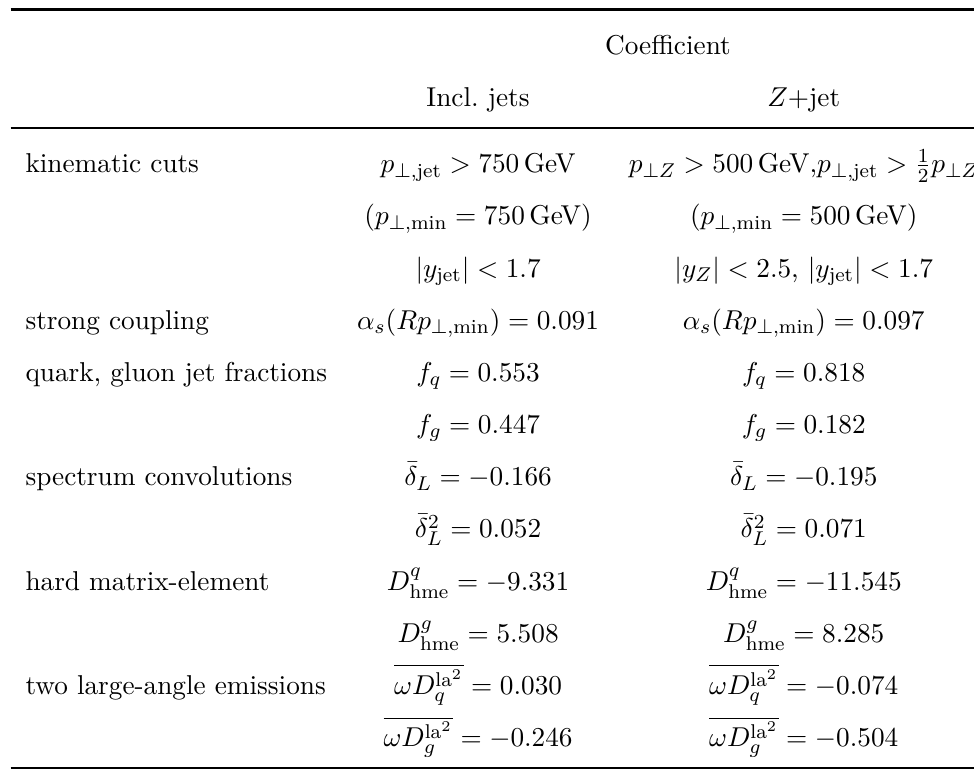
Table 3 . Coefficients entering the NDL h 2 and NNDL h 3 functions for our two jet samples, inclusive jets and Z +jet events with R = 0 . 8 in both